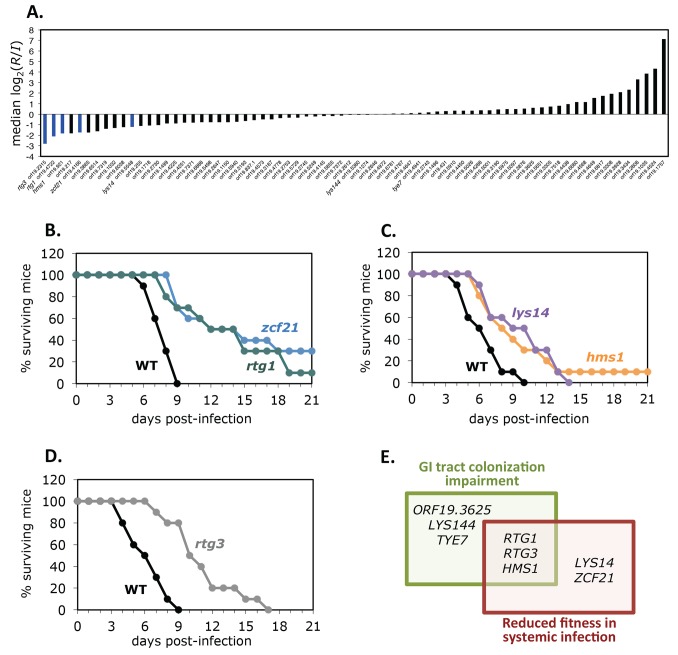
Identification of regulators required for C. albicans systemic infection.(A) Results of the systemic infection screen. Bars represent median log2 (recovered/input) values. (B–D) Virulence analysis of selected mutant deletion strains in monotypic infections. Ten BALB/c mice were infected with wild-type C. albicans or one of the mutant strains by tail vein injection. We used 5.2×105 cells of each strain per infection. Mice were monitored daily and sacrificed when moribund. The logrank test was used for statistical analysis: p<0.0001 for zcf21; p = 0.0008 for rtg1; p = 0.0203 for hms1; p = 0.0166 for lys14; and p = 0.0001 for rtg3. (E) Summary of the TRs displaying phenotypes in the mouse models that we evaluated.